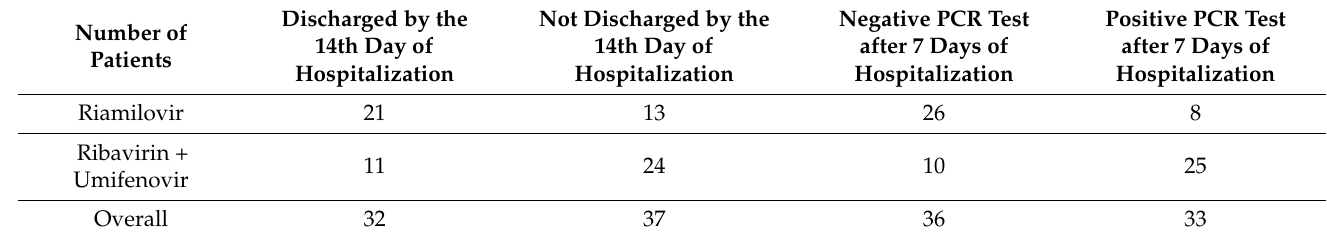
Table 3. Effects of Riamilovir (Triazavirin) and Umifenovir+Ribavirin antiviral therapy on